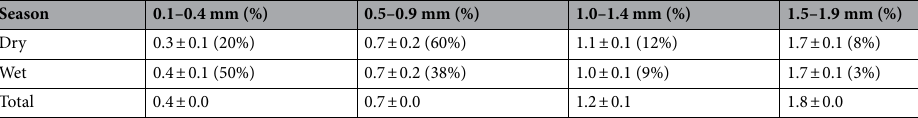
Table 3. Abundance (mean ± SE) and percent contribution (%) of MPs size classes found in thumbprint emperor sampled at Vueti Navakavu LMMA in the dry and wet seasons in Fiji.